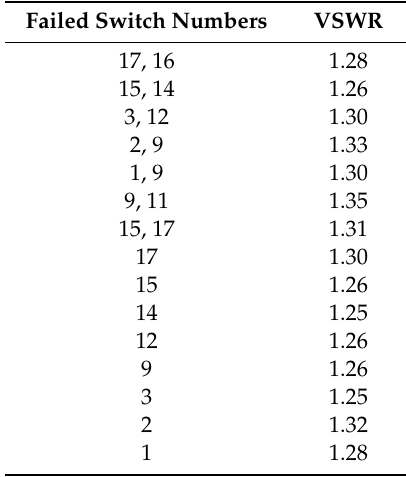
Table 1. Switch failure impact on the average VSWR value.